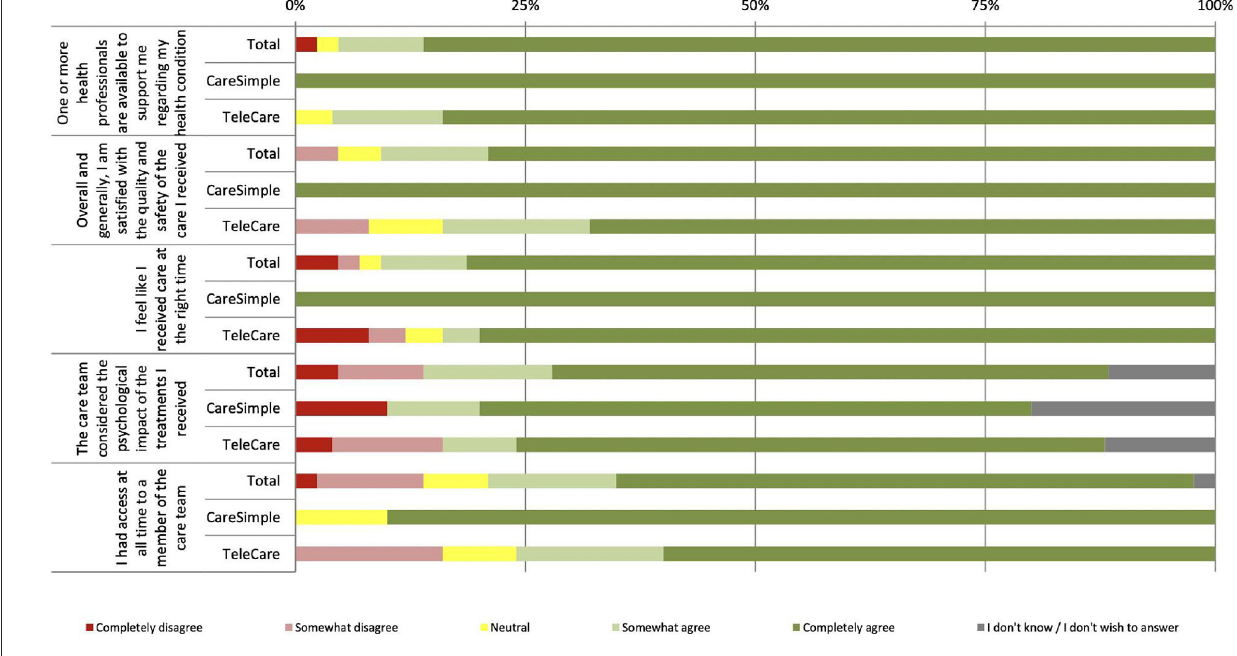
FIGURE 1 | Perception of the quality and safety of care.